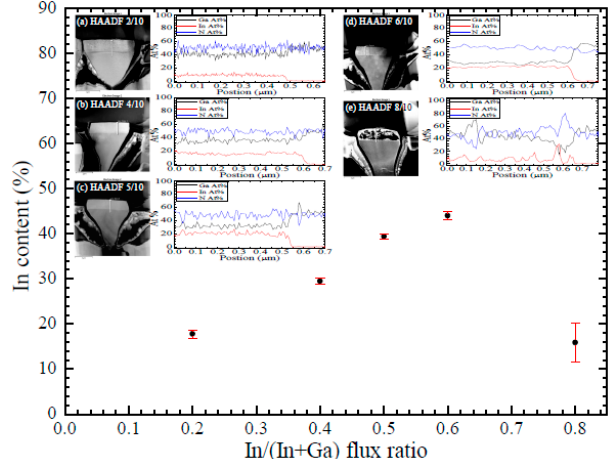
Figure 4. The In contents for sample A to sample E. The insets show the dark field TEM images and the constituent spectra in line scanning mode obtained by EDS, where the scanning lines were marked on the TEM images.